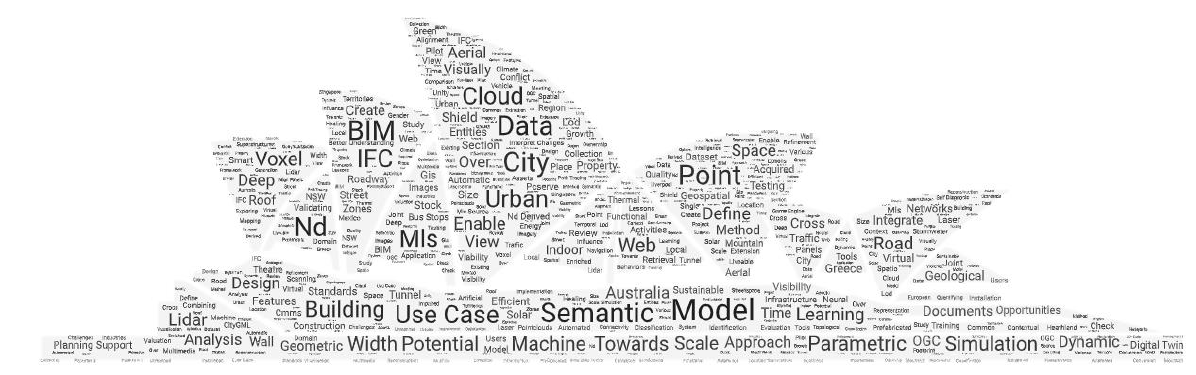
Figure 1: Visualisation of keywords in the shape of Sydney Opera House, Sydney, NSW,